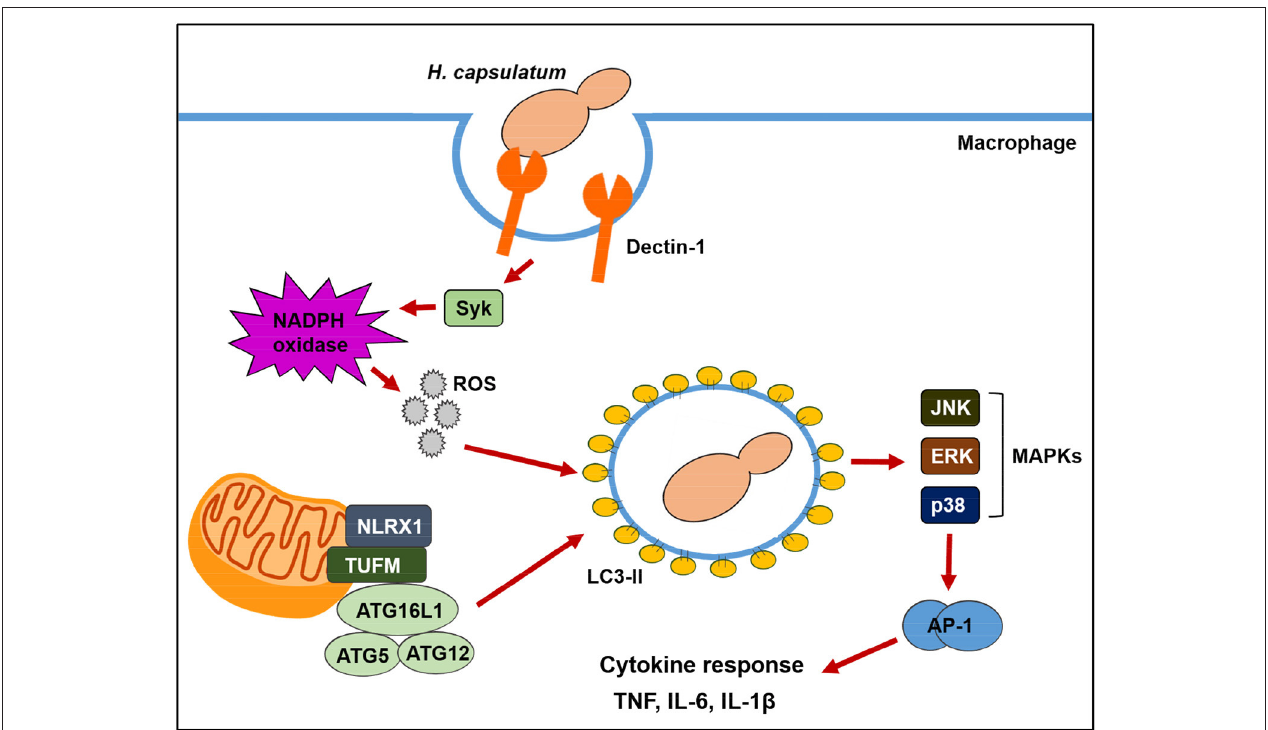
FIGURE 10 | Schematic model of LAP in H. capsulatum -infected macrophage. Upon macrophage encountering H. capsulatum , recognition of fungal β -glucan by Dectin-1 induces Syk phosphorylation. Activation of Syk triggers ROS production through NADPH oxidase. ROS is required for converting LC3-I to LC3-II on phagosomal membrane. Through a mechanism independent of ROS, NLRX1 promotes fungus-induced LAP through its association with TUFM that interacts with ATG5-ATG12 conjugate for LAPosome formation. Both Dectin-1/Syk/ROS-dependent pathway and NLRX1-TUFM complex-dependent pathway collaboratively contribute to LAP induction. The formation of LAPosome promotes downstream MAPKs and AP-1 activation, leading to production of anti-fungal proinflammatory cytokines.